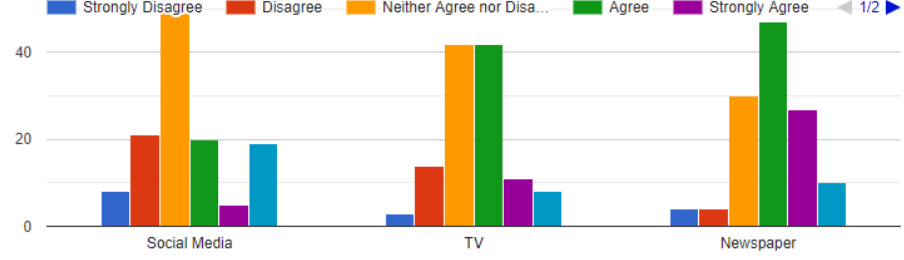
Graph 2: Media Credibility and Authenticity (Source: Authors‟